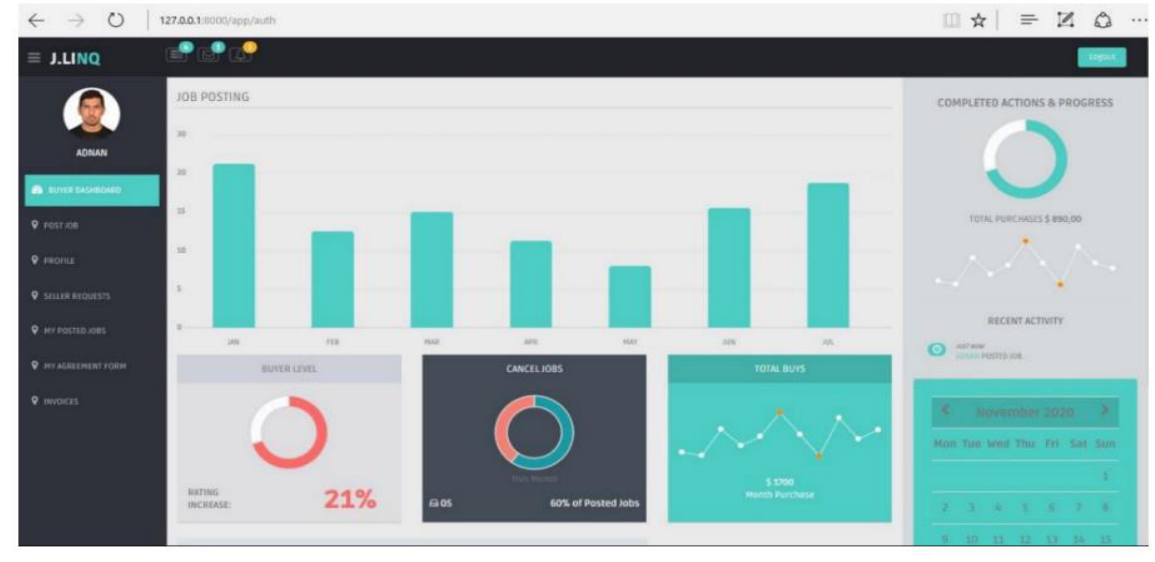
Figure 12. Buyer dashboard and profile.